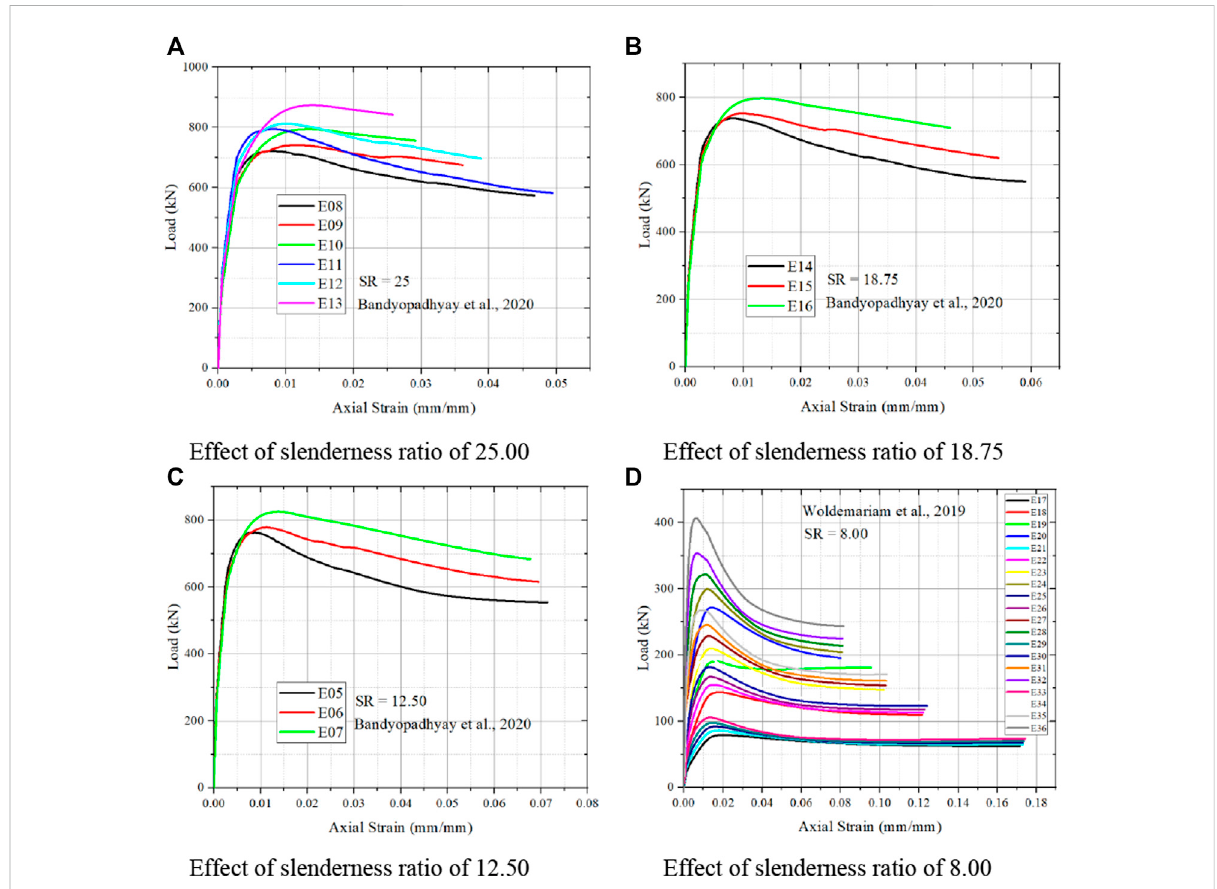
FIGURE 11 Effect of column slenderness ratio on strain and load carrying capacity of CFPT tubes. (A) Effect of slenderness ratio of 25.00. (B) Effect of slenderness ratio of 18.75. (C) Effect of slenderness ratio of 12.50. (D) Effect of slenderness ratio of 8.00.